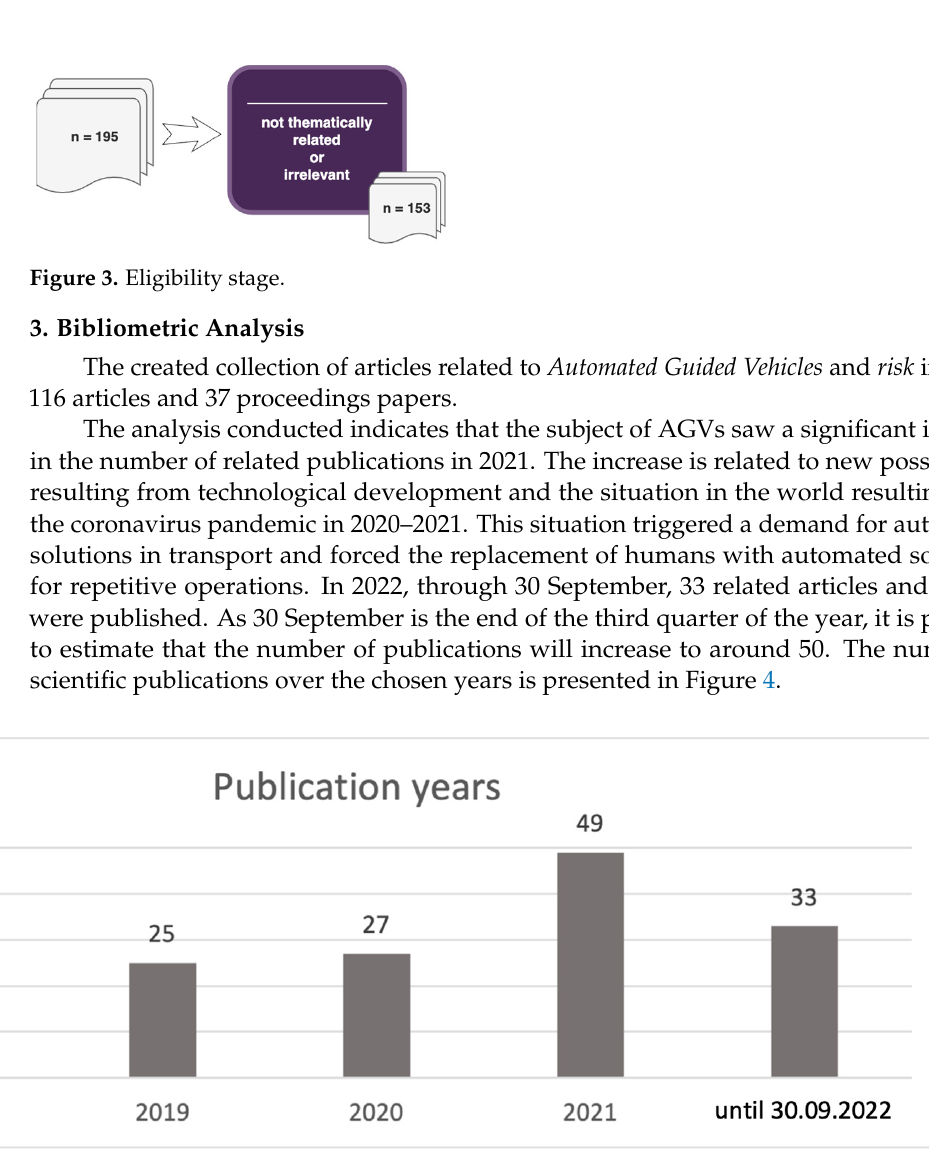
Figure 3. Eligibility stage.